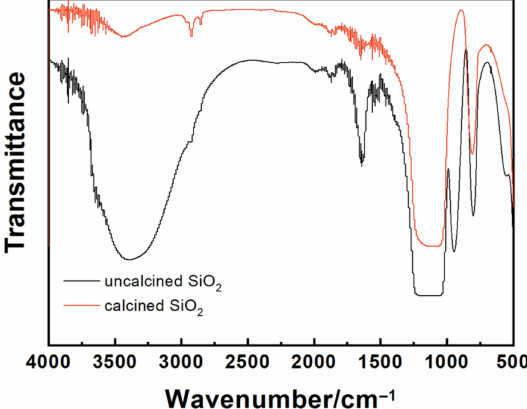
Figure A3. FT-IR spectra of SiO 2